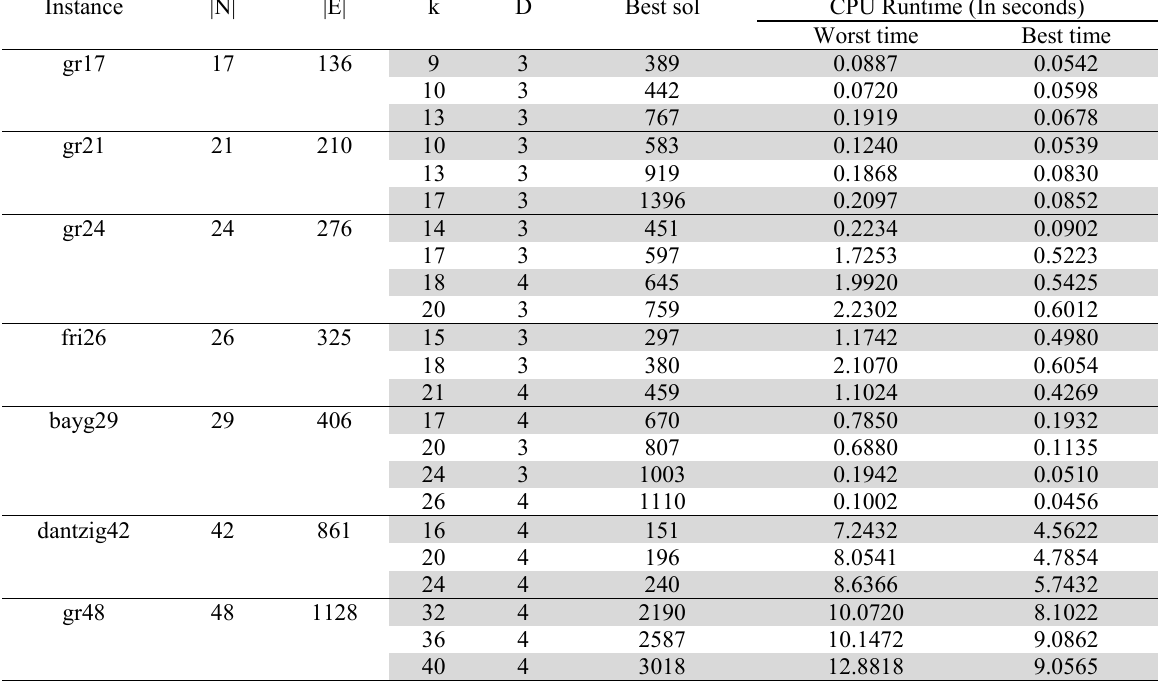
Results of the LSA for k-MSTPD over benchmark instances